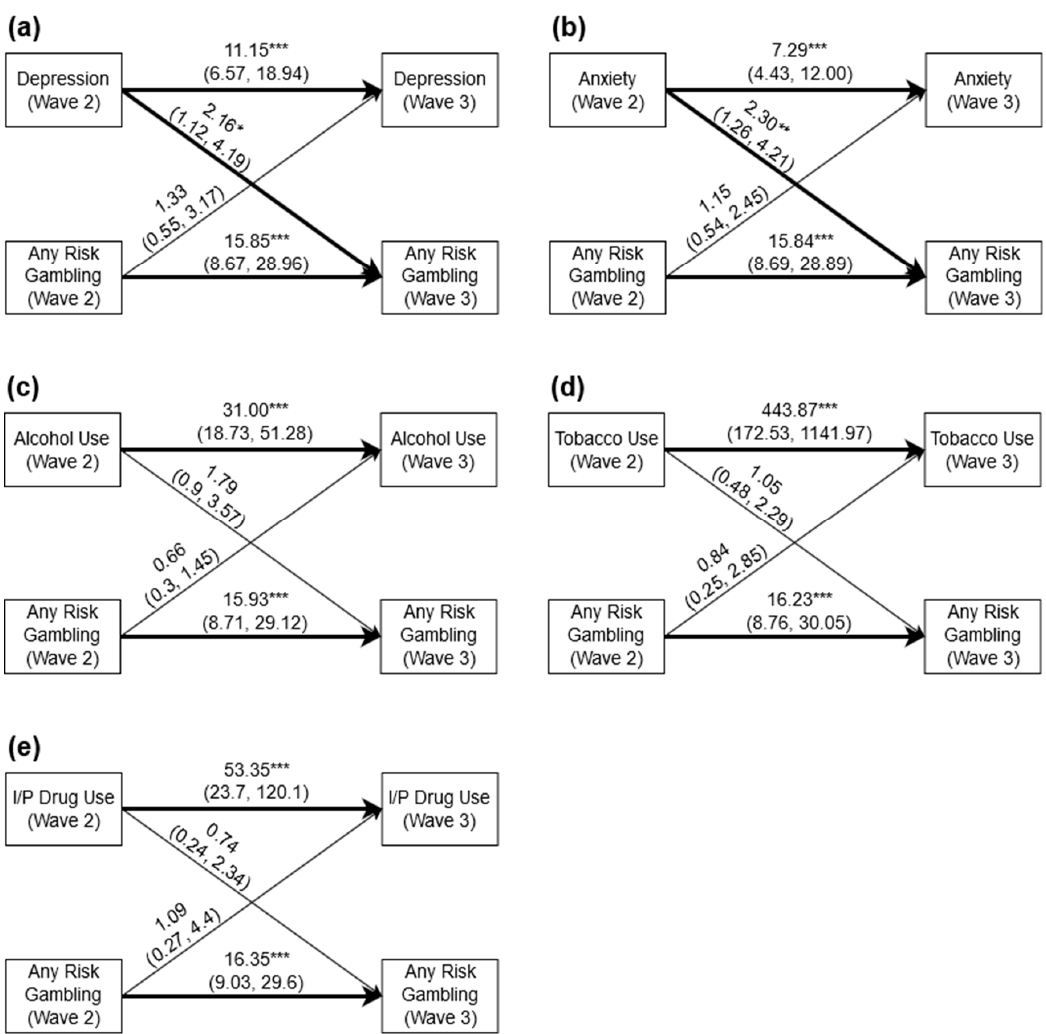
Figure 1. ( a ) Cross-lagged associations between any-risk gambling and depression; ( b ) cross-lagged associations between any-risk gambling and generalized anxiety; ( c ) cross-lagged associations between any-risk gambling and hazardous alcohol use; ( d ) cross-lagged associations between any-risk gambling and daily tobacco use; ( e ) cross-lagged associations between any-risk gambling and drug use. Estimates = odds ratios (95% confidence intervals); I/P = illicit and prescription; * p < 0.05; ** p < 0.01; *** p < 0.001.